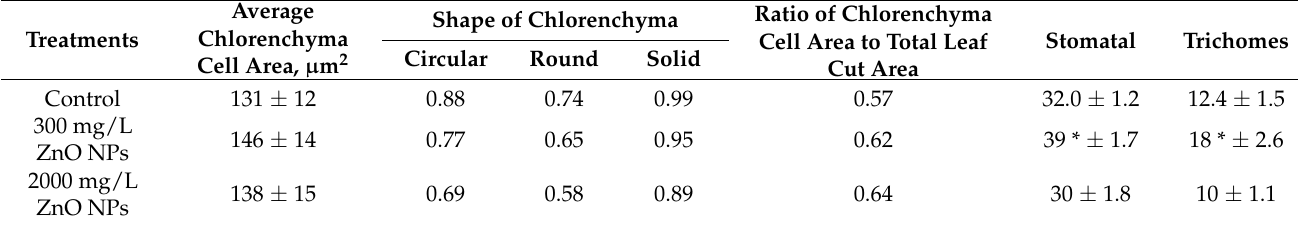
Figure 7. Effects of ZnO NPs of stomata and trichome morphology of H. sativum , adaxial surface of leaf showed by sub-figures ( a ) control, ( b ) 300 mg/L ZnO NPs, and ( c ) 2000 mg/L ZnO NPs. Red arrows indicate trichomes and stomata. Table 2. The average chlorenchyma cell area, shape, and ratio of chlorenchyma cell area to total leaf cut area, and stomata and trichome area in H. sativum